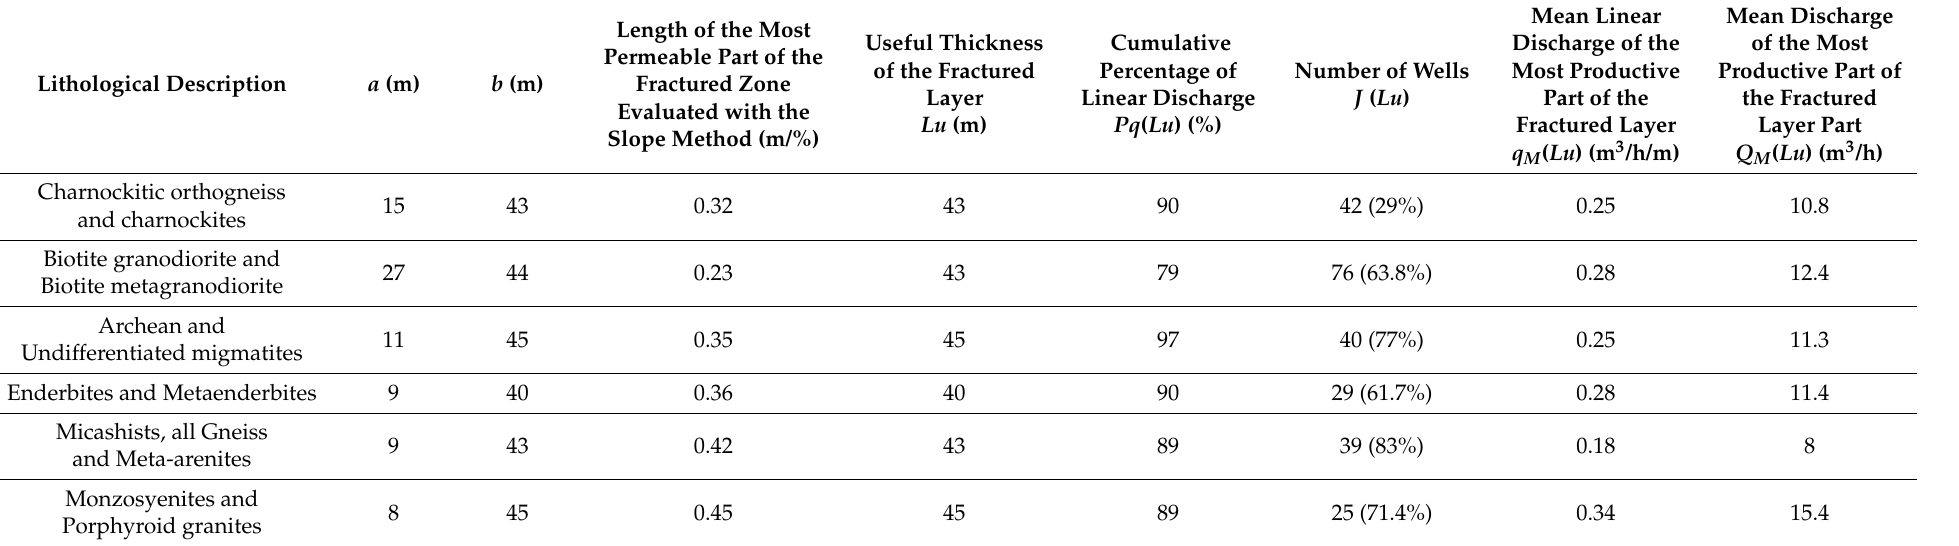
Table 8. Mean properties of the fractured layer evaluated with the slope method for the various hard